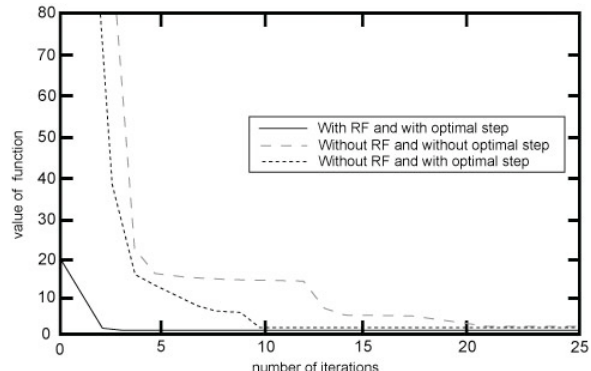
Fig. 9 – Influence of Eq. 22 and of use of the optimum step in the gradient method - Set of data with 44